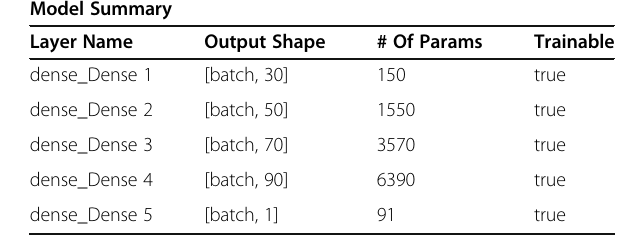
Table 3 Topology of the model Model